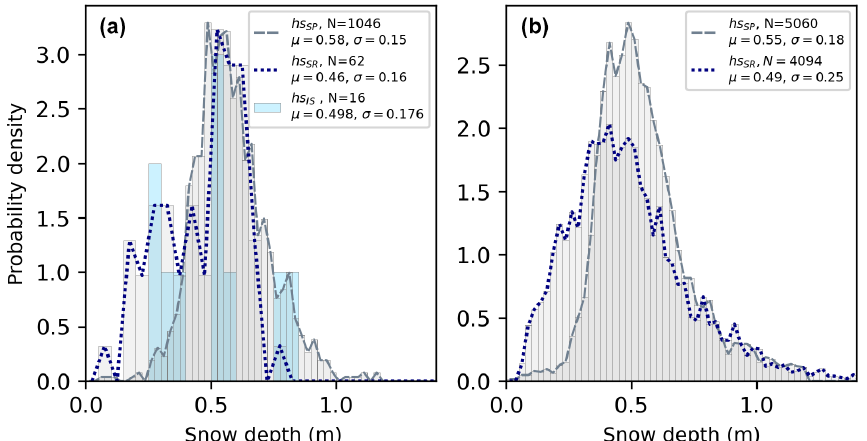
Figure 5. Probability density functions of snow depth measurements with given average values ( µ ), standard deviations ( σ ) and number of measurements ( N ) from (a) the 2-D survey field site obtained with the snow probe (grey dashes), the OIB snow radar (blue dots) and drill holes (light blue bars) and (b) from the wider surroundings from snow probe sampling during the entire N-ICE2015–Floe 2 campaign (grey dashes) and from OIB snow radar within a radius of 10km around the position of R/V Lance (blue dots).